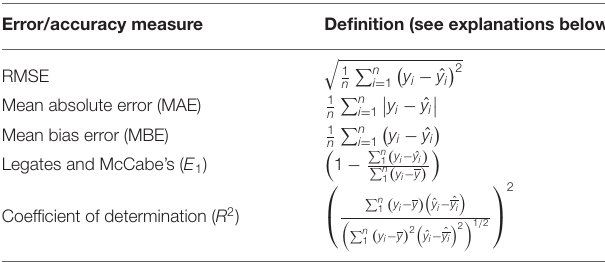
TABLE 3 | Definitions of comparison indicators [after Li (2017),